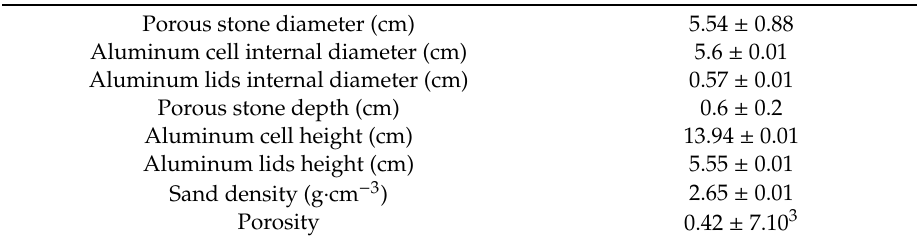
Table 2. Aluminum cell and porous stone